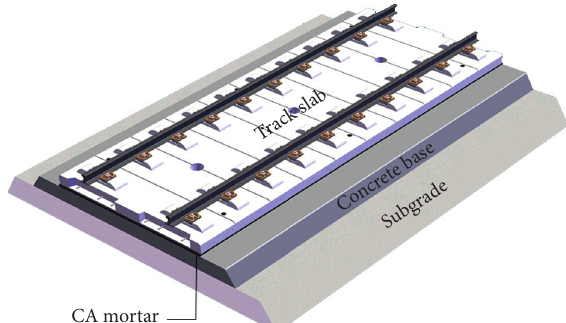
Figure 1: Diagram of the CRTS II SBTS on